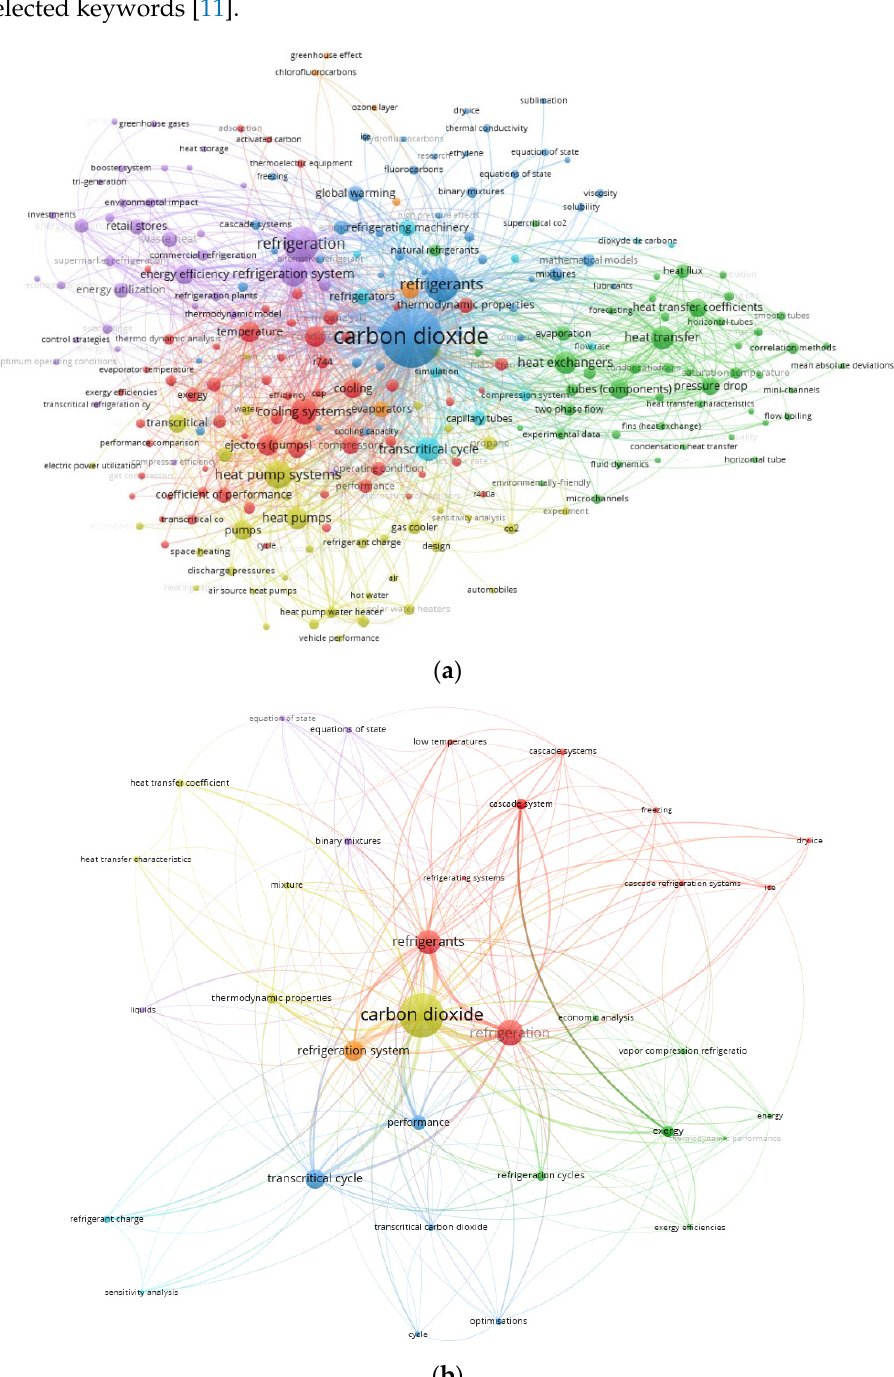
Figure 3. Co ‐ occurrence and links among the keywords (by VOSviewer): ( a ) keyword “carbon di ‐ Figure 3. Co-occurrence and links among the keywords (by VOSviewer): ( a ) keyword “carbon oxide”, time period 1921–2021, and ( b ) filter “refrigeration”, time period 2000–2021. dioxide”, time period 1921–2021, and ( b ) filter “refrigeration”, time period